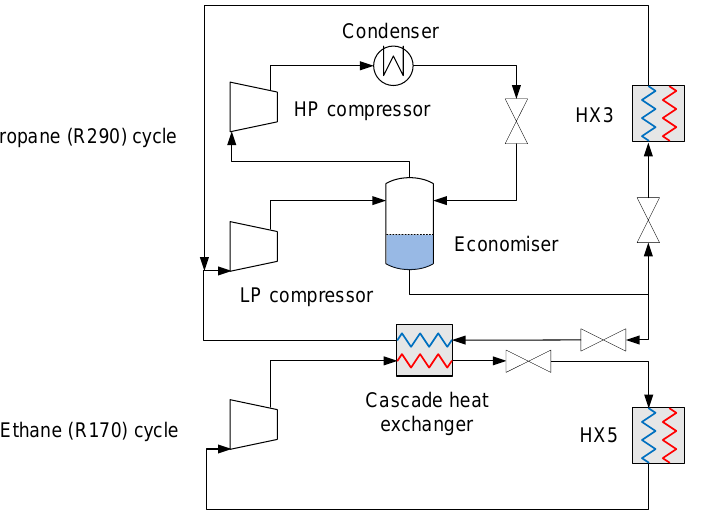
Figure 11. Basic layout of the auxiliary propane/ethane (R290/R170) cascade refrigeration cycle.